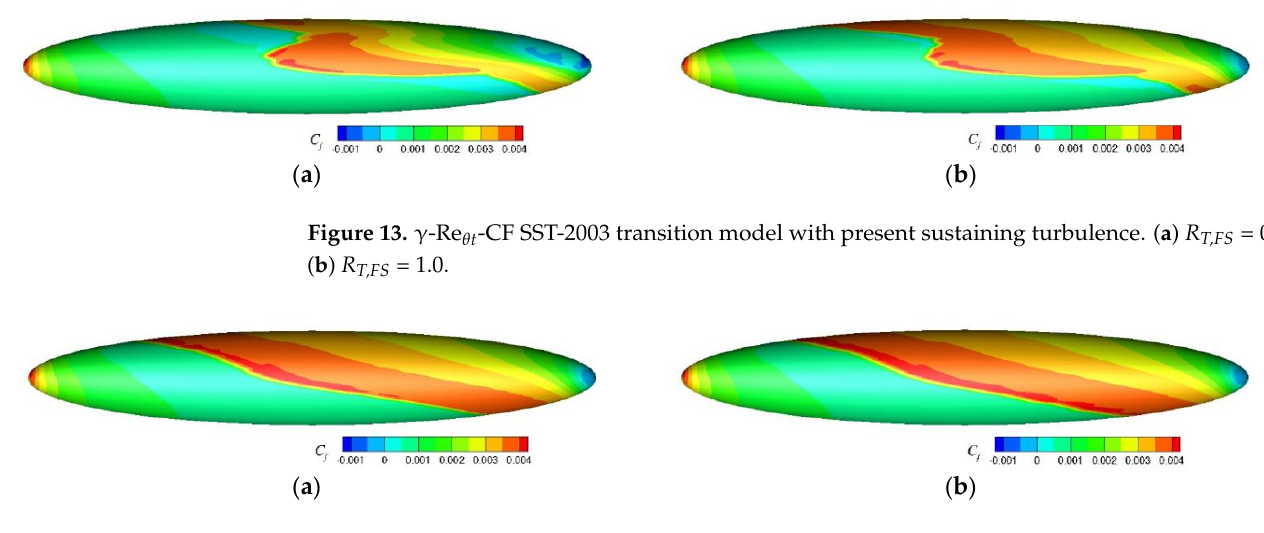
Table 3. Drag coefficients for different approaches.